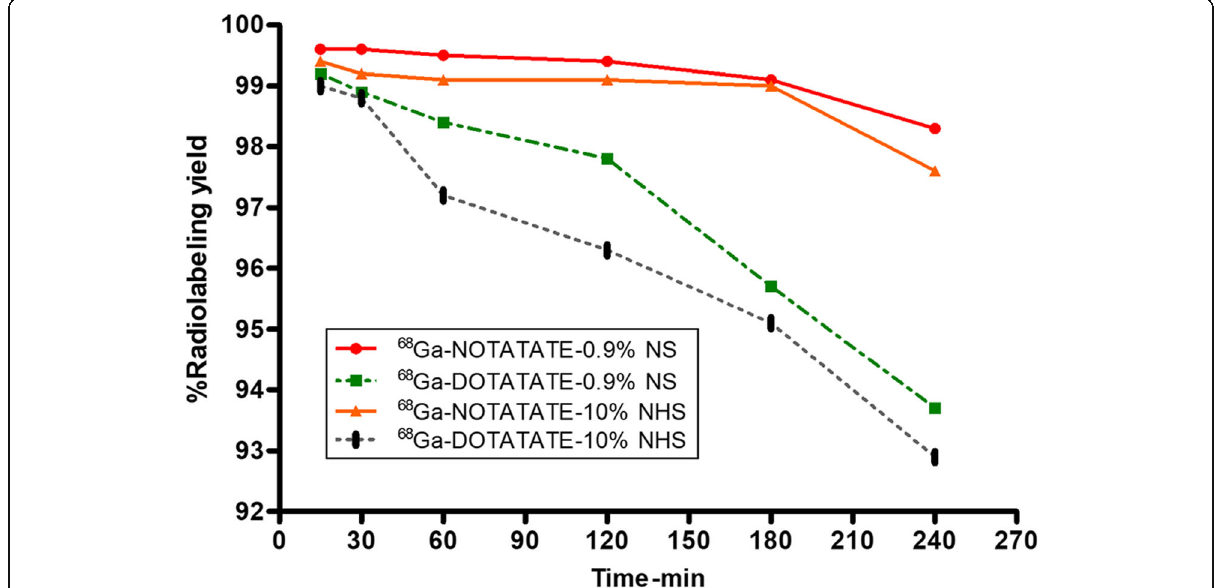
Fig. 3 The in vitro stabilities under different conditions of 68 Ga-NOTA-TATE and 68